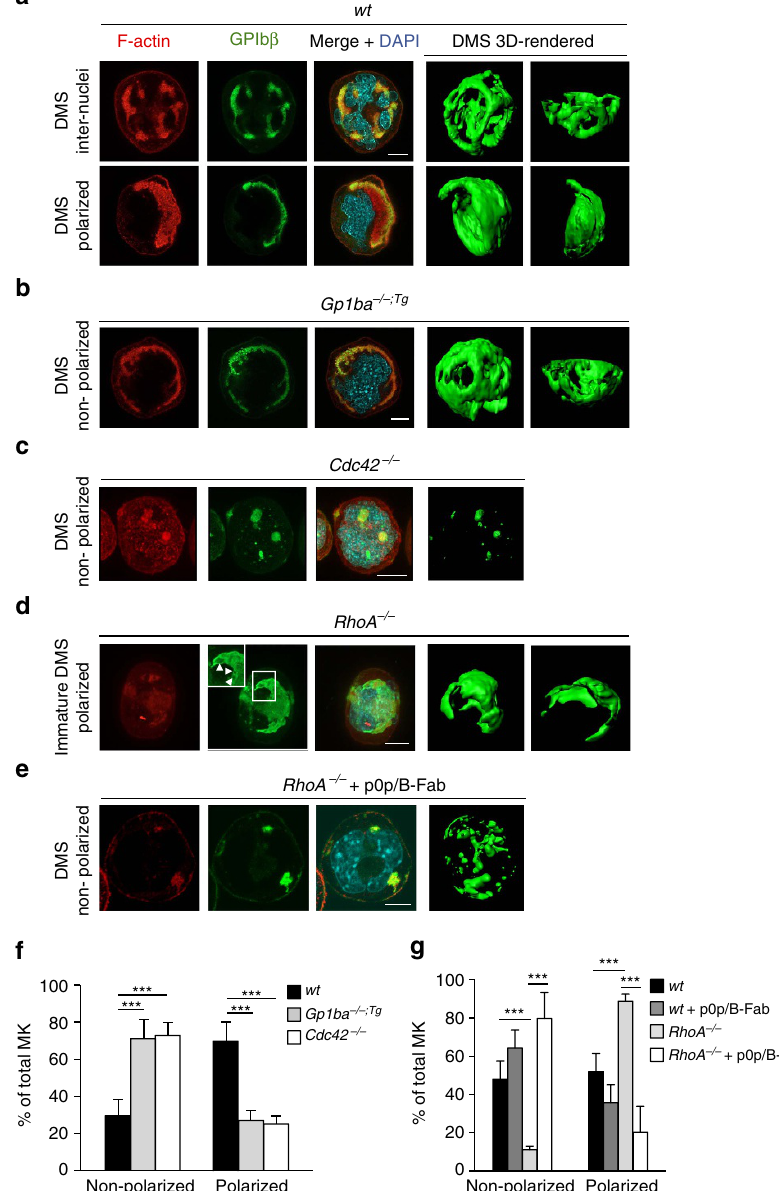
Figure 5 | RhoA controls GPIb a /Cdc42-dependent MK polarization. ( a – e ) Representative confocal images of in vitro differentiated MKs reveal polarized DMS in mature wt MKs ( a ), defective polarization in Gp1ba (cid:2) / (cid:2) ;Tg ( Gp1ba-Tg ) ( b ) and Cdc42 (cid:2) / (cid:2) MKs ( c ), increased polarization in RhoA (cid:2) / (cid:2) MKs ( d ) and defective polarization of RhoA (cid:2) / (cid:2) MKs after treatment with GPIb a -blocking monovalent Fab fragments, p0p/B-Fab ( e ). F-actin is stained by phalloidin (red); GPIb b ( a – d ) or GPIX ( e ), green; DAPI, blue. 3D surface rendering of respective z-stacks (Imaris software; right panel). n ¼ 5 biological replicates. Scale bar: 10 m m. ( f ) Quantification of DMS polarization shows reduced MK polarization in Gp1ba-Tg (light grey) and Cdc42 (cid:2) / (cid:2) (white) MKs compared to the wt (black) ( n ¼ 5 biological replicates). ( g ) MK polarization is increased in RhoA (cid:2) / (cid:2) MKs (light grey) compared to the untreated wt (black) and wt MKs treated with p0p/B-Fab fragments (dark grey). Treatment of RhoA (cid:2) / (cid:2) MKs with p0p/B-Fab fragments (white) reverts the hyperpolarization. n ¼ 5 biological replicates ( wt and RhoA (cid:2) / (cid:2) ) and 2 biological replicates ( wt þ p0p/B-Fab and RhoA (cid:2) / (cid:2) þ p0p/B-Fab). Bar graphs represent mean ± s.d. Two-way ANOVA with Bonferroni correction for multiple comparisons; *** P o